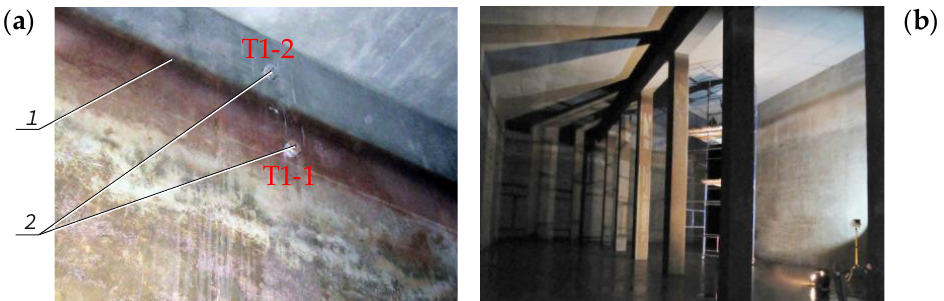
Figure 5. Photos from the inside of tested tanks for fresh water: ( a ) a fragment of the internal wall and floor slab of the tank: 1 — smudge of water in the tank, 2 — cylindrical concrete cores drilled below and above the line 1 that indicates water level in the tank; and ( b ) perimeter and internal walls, columns and beam from the reinforced concrete frame that supports the floor slab of the tank.